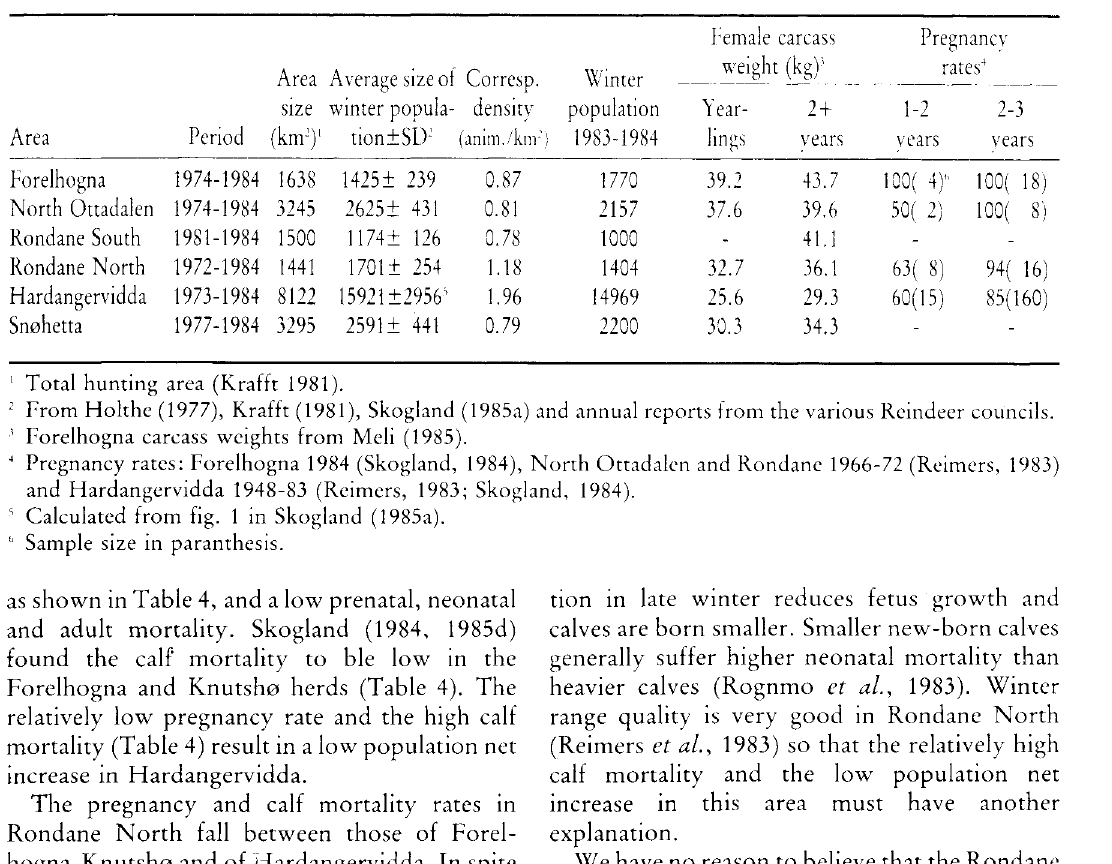
Table 3. Average population net increase ±SD and annual harvest ±SD.